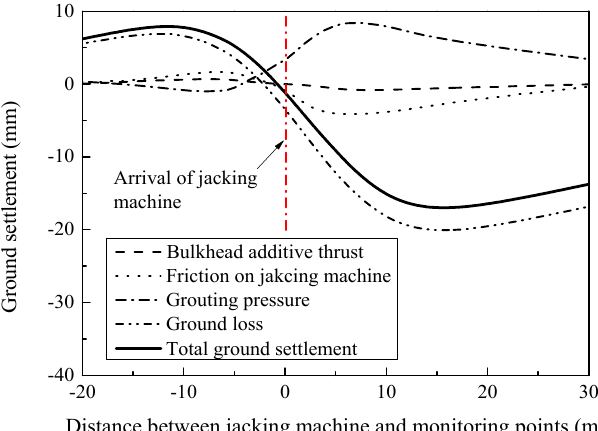
Figure 11. Proportions of influence factors on overall ground settlement.